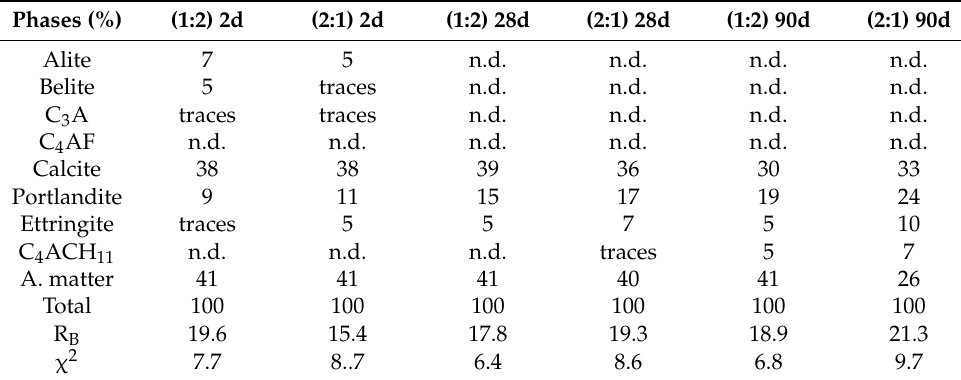
Table 7. Mineralogical composition of 7% Hst/glass